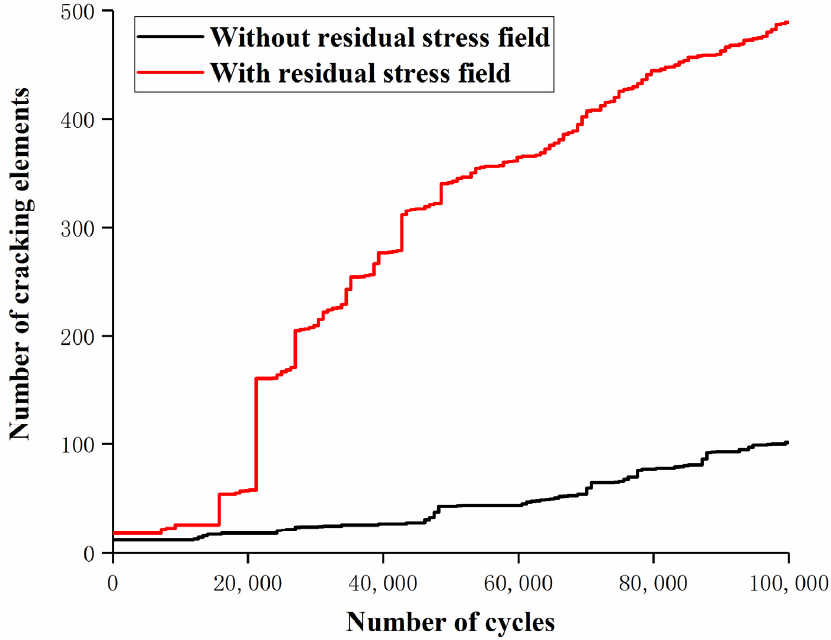
Figure 20. Relationship between the number of cracked elements and number of load cycles for with a maximum displacement load of 0.35 mm.